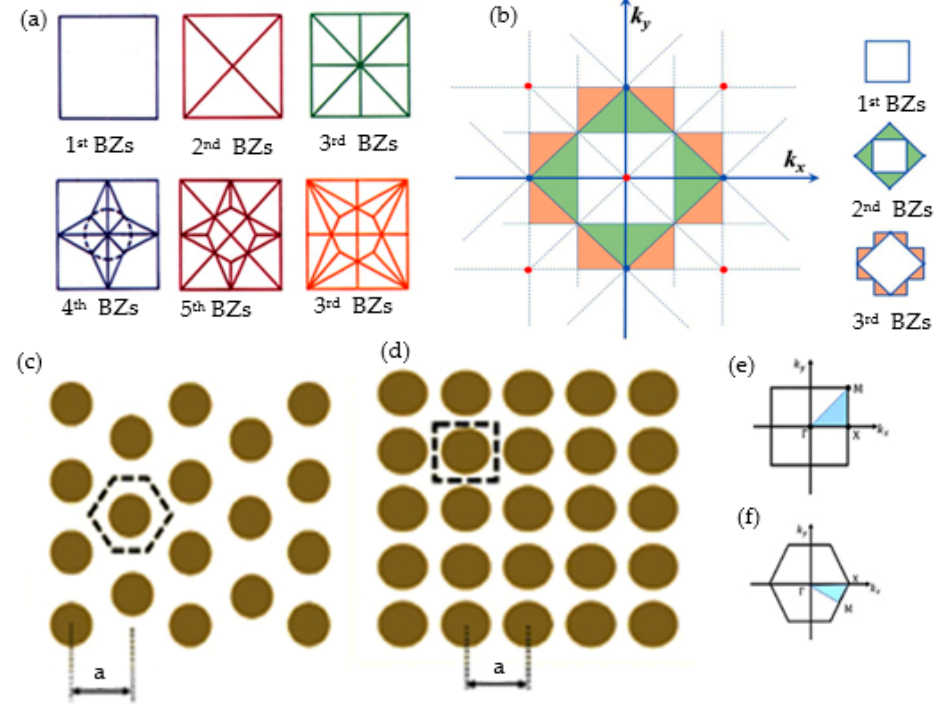
Figure 4. Schematic representation of lattice shapes for different vases of SMs: ( a ) square lattice; ( b ) honeycomb lattice; Irreducible Brillouin zone (IBZ) of square; ( c ) honeycomb; ( d ) lattice; First Brillouin zone of square; ( e ) honeycomb; ( f ).